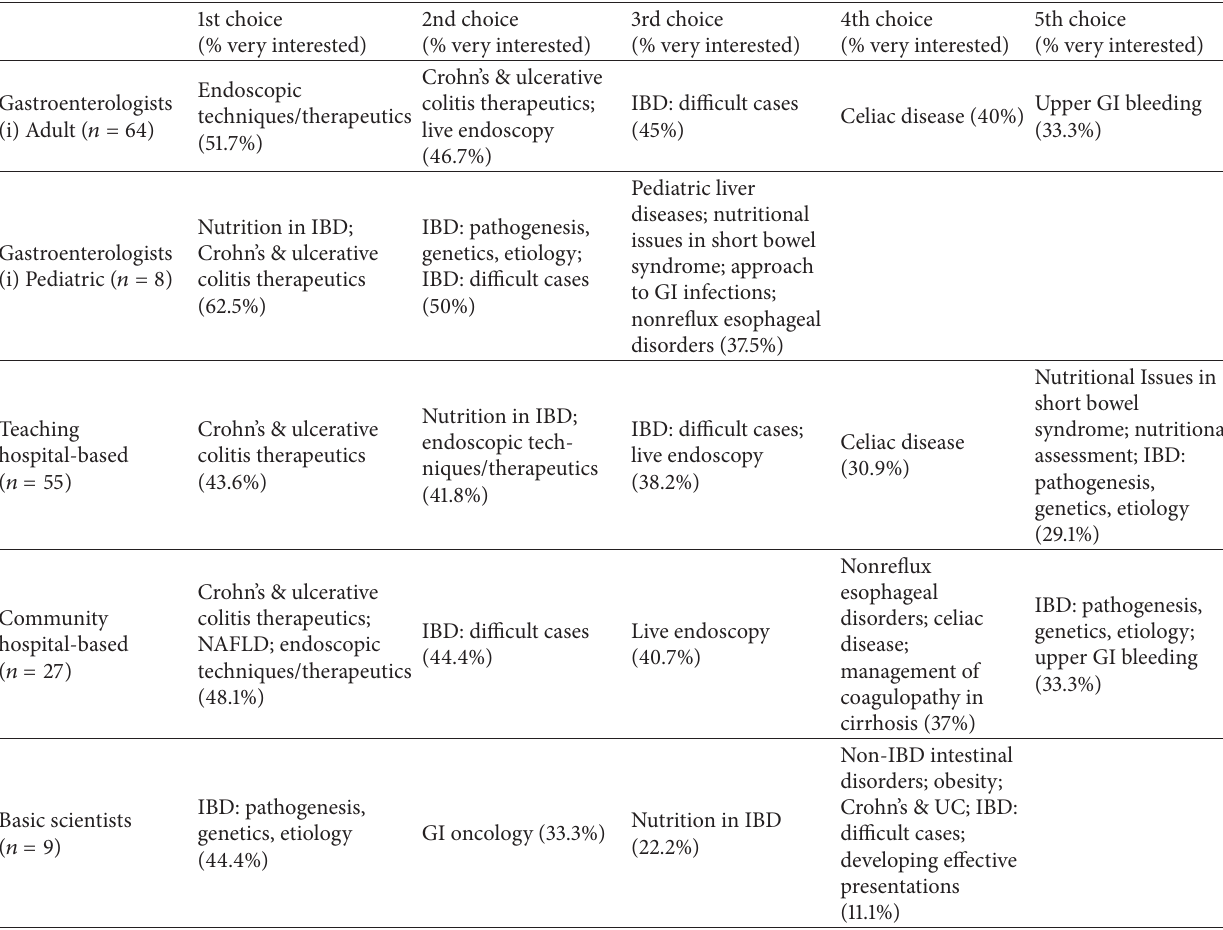
Table 1: Most popular educational topics by respondent subgroup. Crohn’s: Crohn’s disease; UC: ulcerative colitis; GI: gastrointestinal; IBD: inflammatory bowel disease; IBS: irritable bowel syndrome; NAFLD: nonalcoholic fatty liver